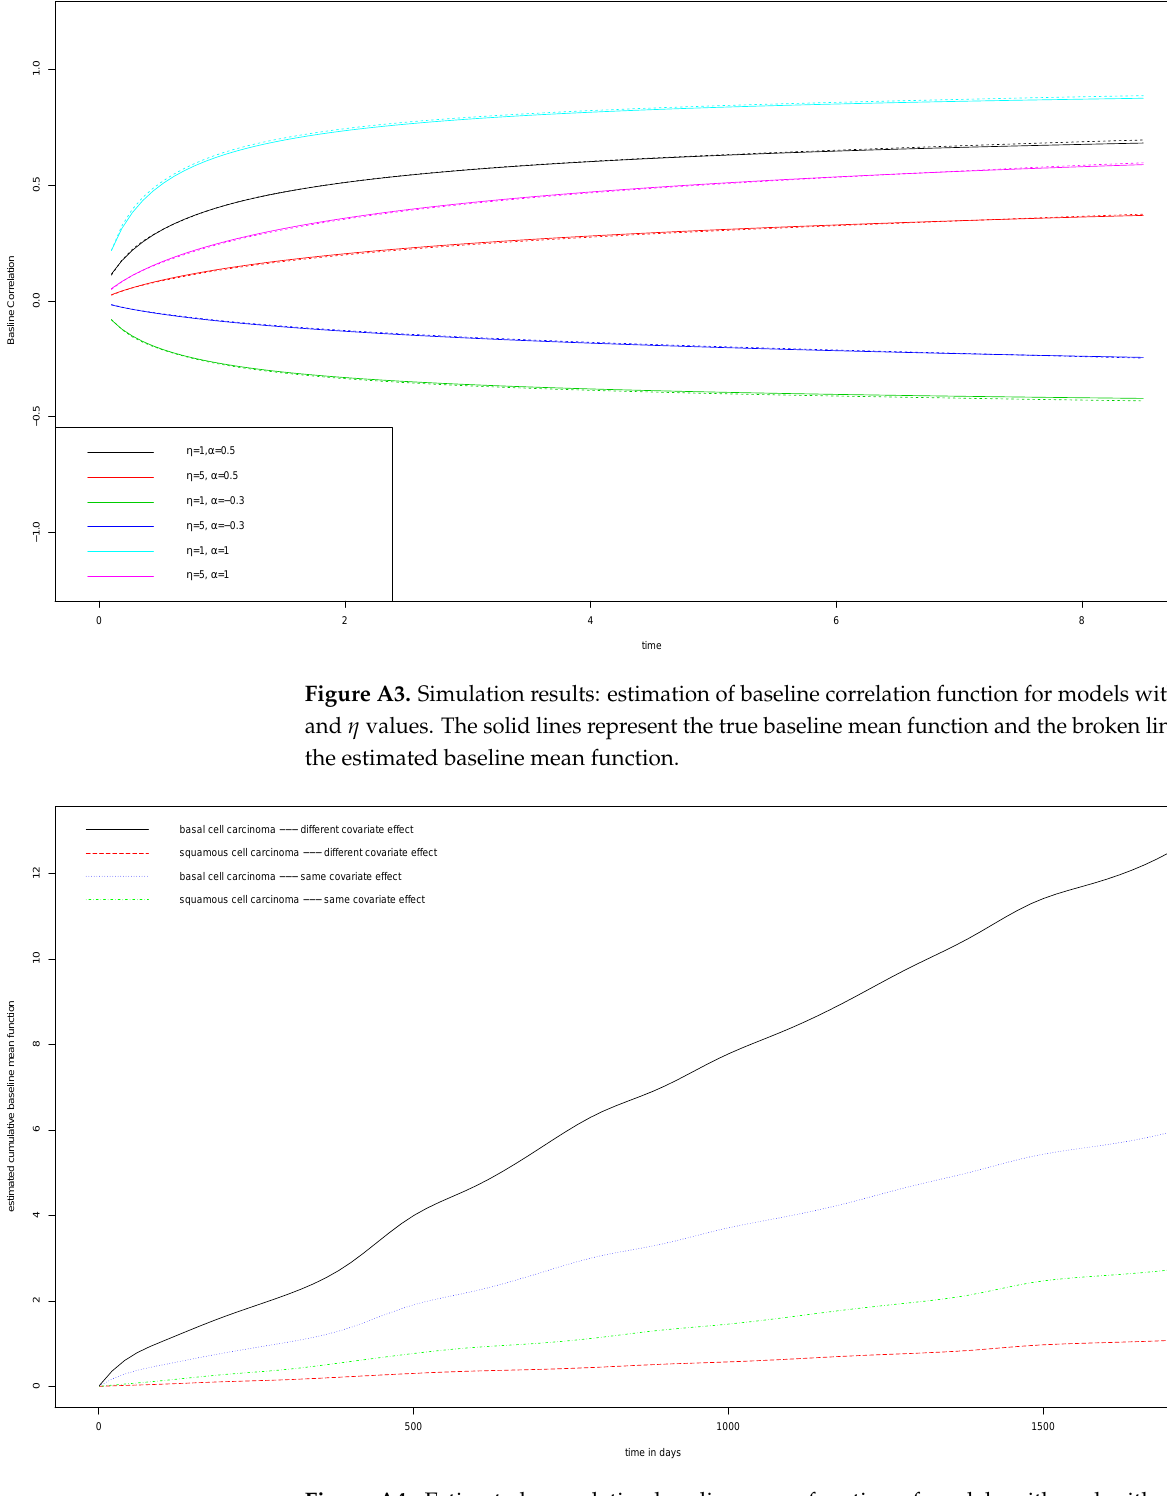
Figure A4. Estimated cumulative baseline mean function of models with and without the same covariate effects for basal cell carcinoma and squamous cell